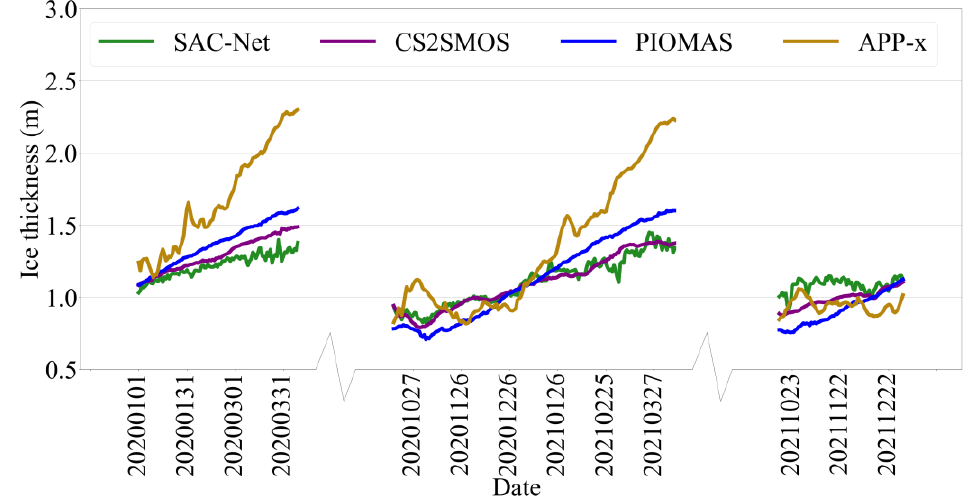
Figure 6. Comparison of daily average SIT from different SIT products in winter during 2020–2021. The lines in green, purple, blue, and brown denote the trend of SIT from SAC-Net thermodynamically estimated, CS2SMOS estimated, PIOMAS estimated, and APP-x estimated SIT with time. The spatial distribution of SIT was derived from five selected parameters from the gridded ERA5 reanalysis data using SAC-Net. See Figure 7 for the SAC-Net derived SIT distribution on March 15th and 15 October 2020 and the differences with the other three products. As the target value of open water in the training dataset was set to − 0.1 to avoid the influence of small data fluctuations, any value less than 0 in the obtained results was designated as 0. All distributions were cropped to a size of 282 × 282, projected onto the WGS 1984/NSIDC Sea Ice Polar Stereographic North grid with a spatial resolution of 25 km, and land-masked. Figure 7a shows that the sea ice edge is well defined by the SAC-Net SIT because of the substantial difference in thermodynamic parameters between the ice and water. On March 15th, the sea ice with a thickness of more than 2 m mainly appears in northern Greenland and the northern Canadian Archipelago, while the other areas are mainly the new ice, young ice, and the first-year ice during the Arctic freezing period, with obvious gradient change law. On October 15th, after summer melting, the original thick sea ice becomes thinner as a whole, and the original thin sea ice completely melts and disappears. The difference maps with the results of CS2SMOS show there is little difference between them, and the SIT from SAC-Net is slightly higher on 15th October (Figure 7b).